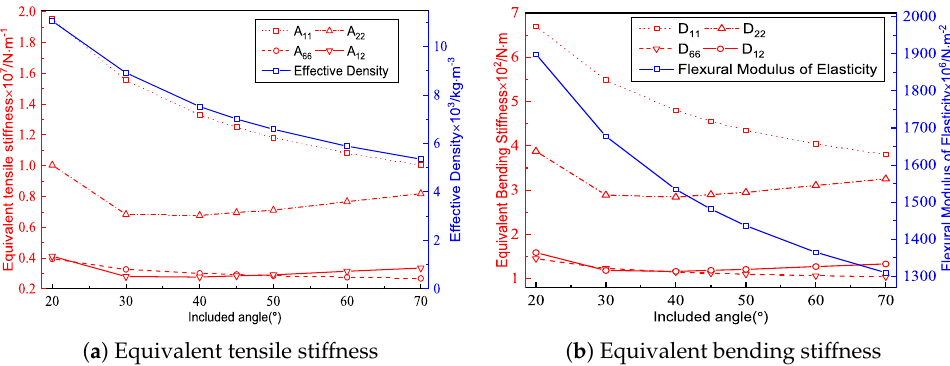
Figure 6. Effects of the included angles on the equivalent stiffness of the triangular